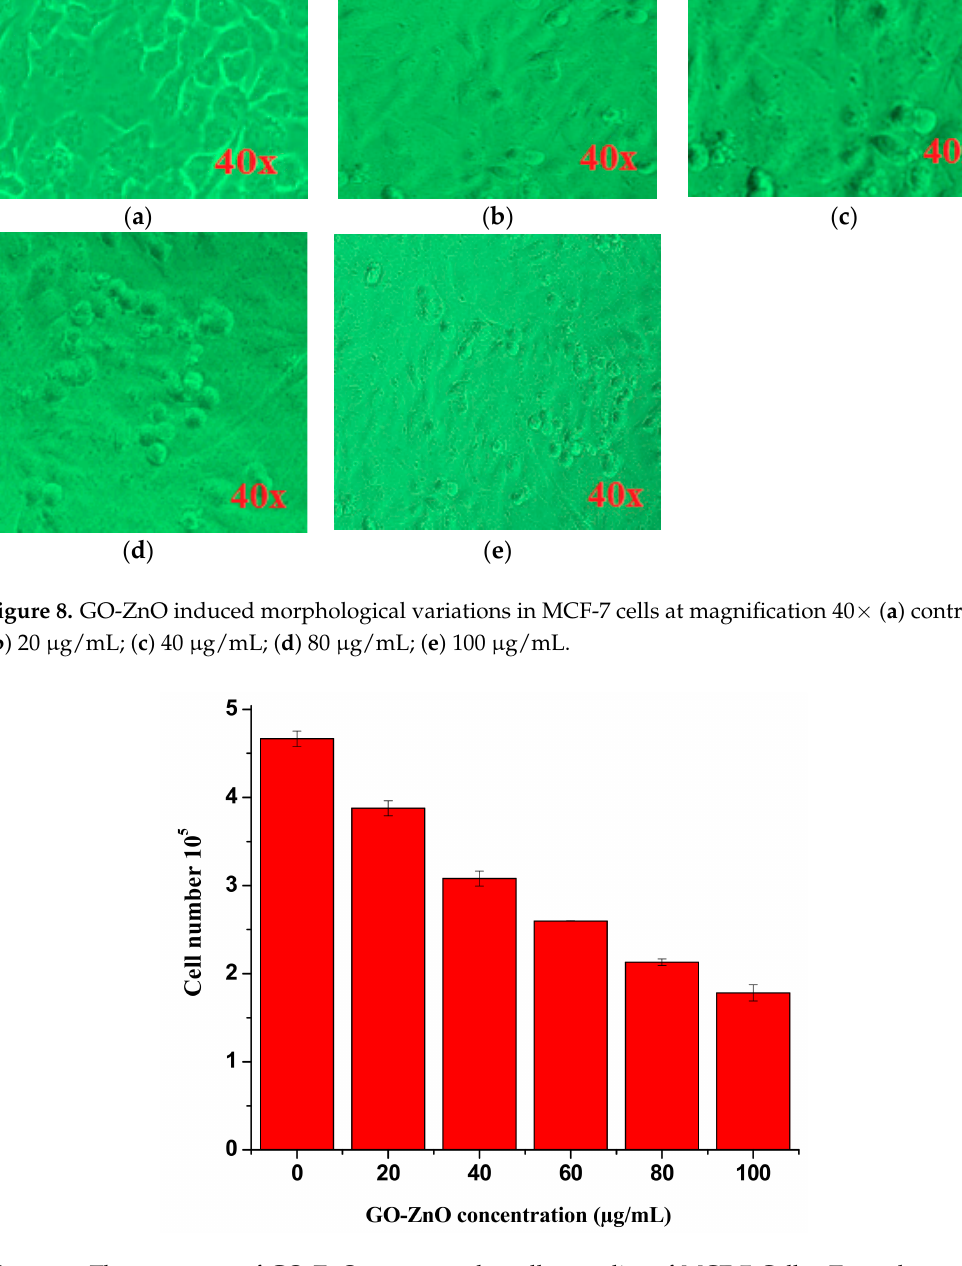
Figure 9. The outcomes of GO-ZnO represent the cell mortality of MCF-7 Cells. Treated groups displayed the statistically significant differences from the control group, as measured by the Student’s t -test ( p < 0.05).